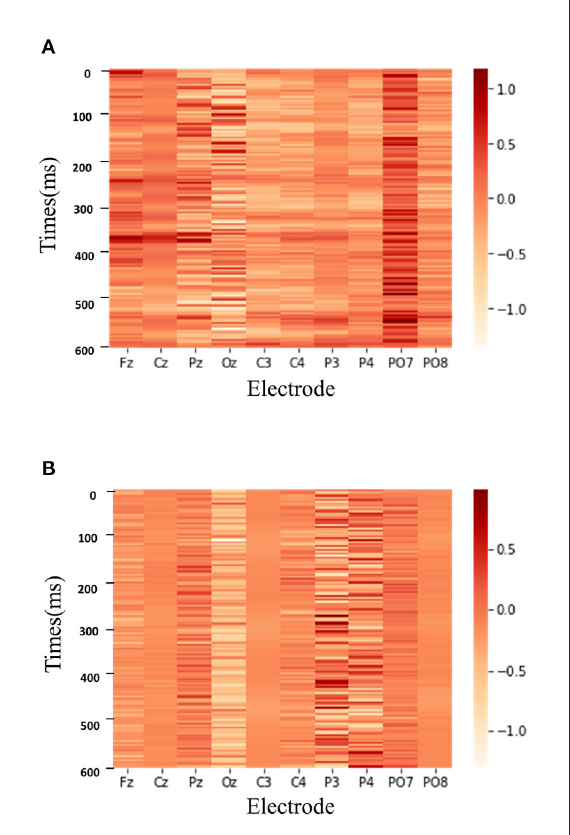
FIGURE7 The two classes heatmap result of DAFM on the BCI Competition II dataset. (A) P300 signal. (B) Non-P300